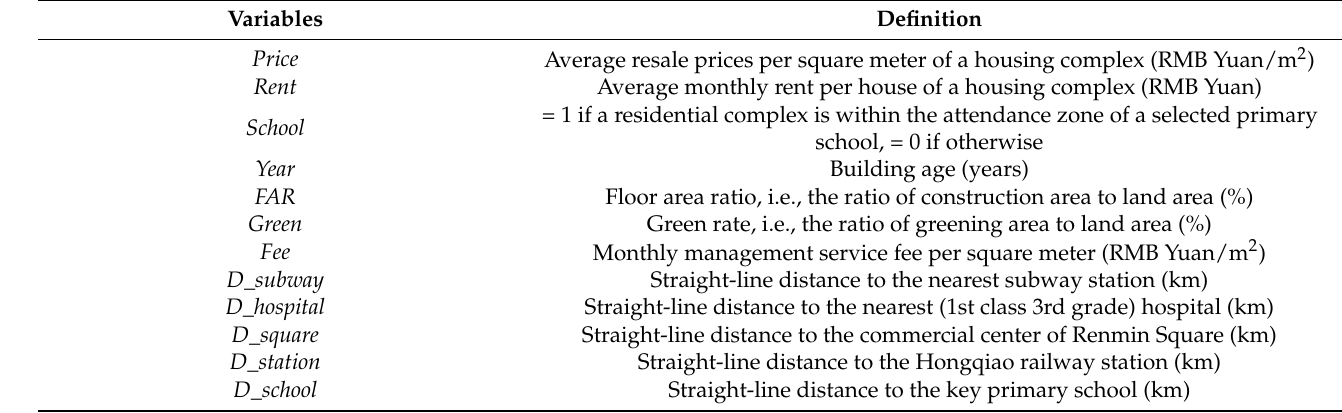
Table 1. Variable